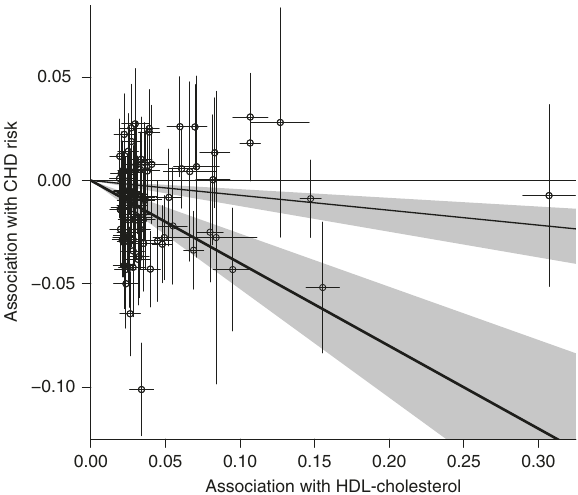
Fig. 2 Scatter plot of genetic associations. Genetic associations with HDL- cholesterol (standard deviation units) against genetic associations with CHD risk (log odds ratios). These association estimates are the inputs for the contamination mixture method. Error bars for genetic associations are 95% con fi dence intervals. Heavy black line is the causal estimate from the contamination mixture method with the strongest signal, lighter black line is the causal estimate from the secondary peak. The grey area is the 95% con fi dence interval for the causal effect; this comprises two ranges as the likelihood is